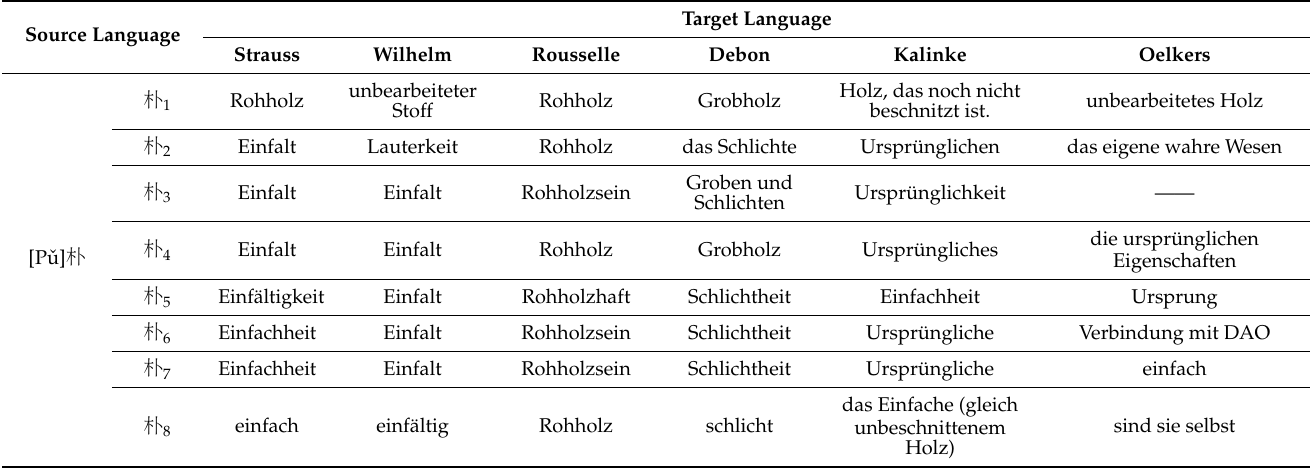
Table 7. Pˇu 朴 in the German Translation of the D à o D é J¯ıng .